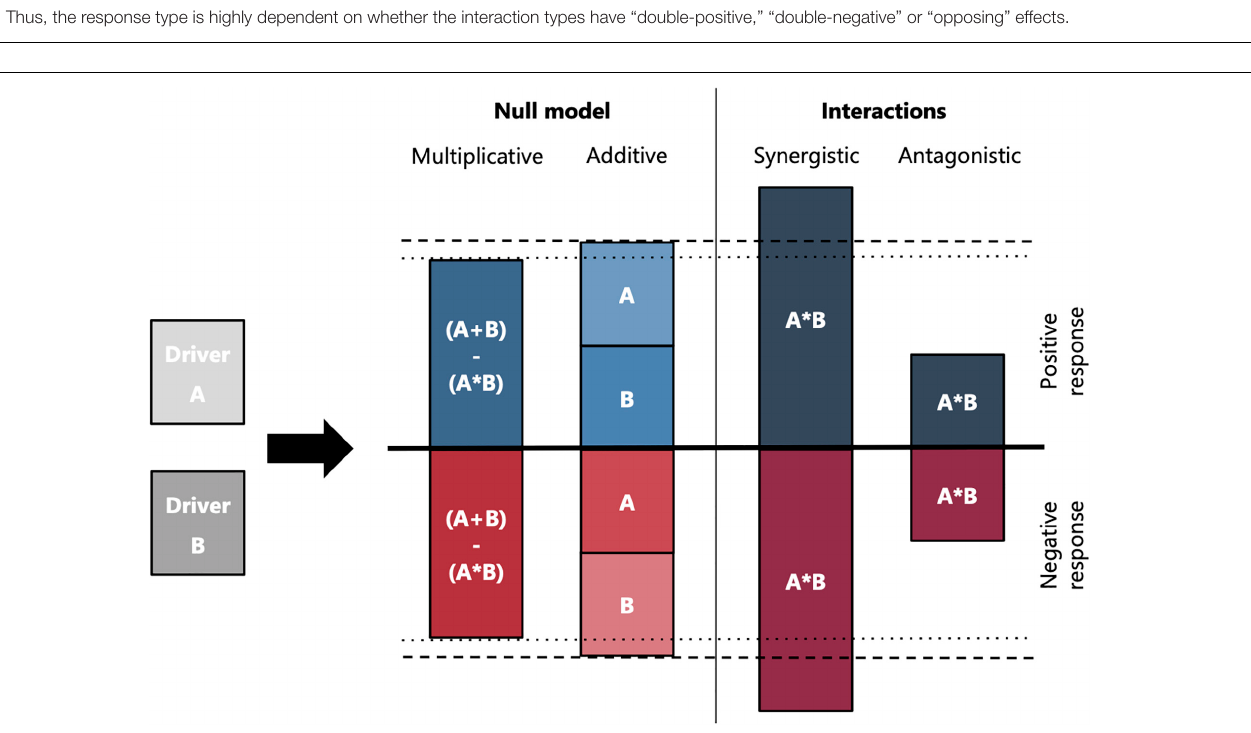
FIGURE 2 | Overview of different driver interactions between two drivers. The interactions can be classified by using two different null models. The additive null model (A+B) is derived by building the sum of the interactions. A multiplicative null model (A+B–A*B) can correct over-estimations for factors such as mortality. Either of the classifications can be assigned a synergistic or antagonistic interaction of the drivers, which can act beneficial or deleterious compared to the null model. The height of bars indicates the magnitude of the response and the direction indicates a positive or negative response compared to a control (e.g., undisturbed habitat). The dashed lines indicate the magnitude of a multiplicative and additive null model,